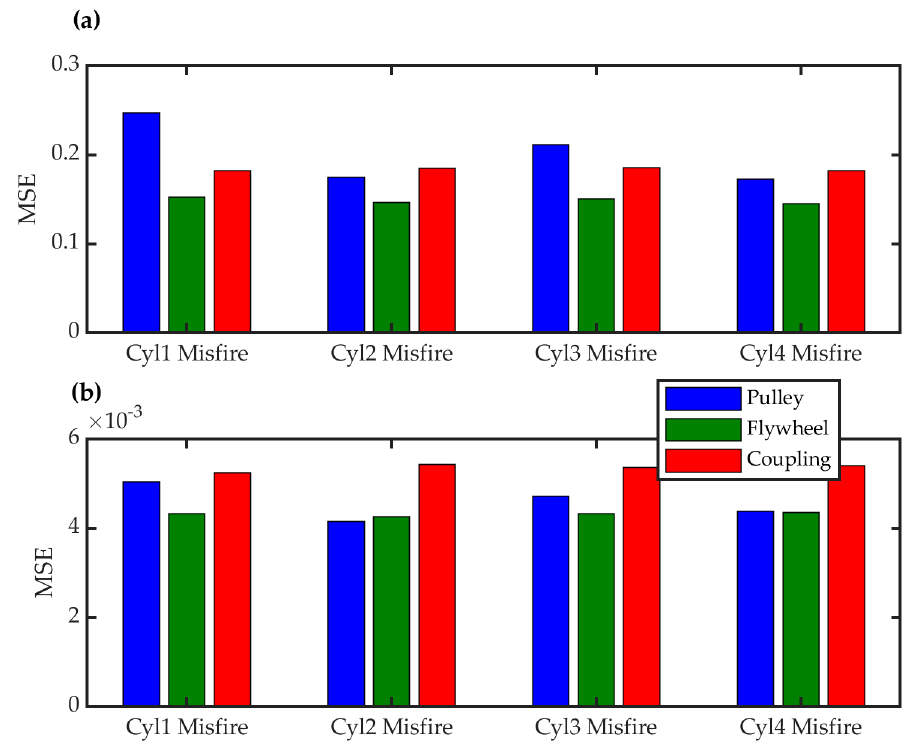
Figure 13. MSE of the IAS signals in: ( a ) the angular domain; ( b ) the frequency domain.